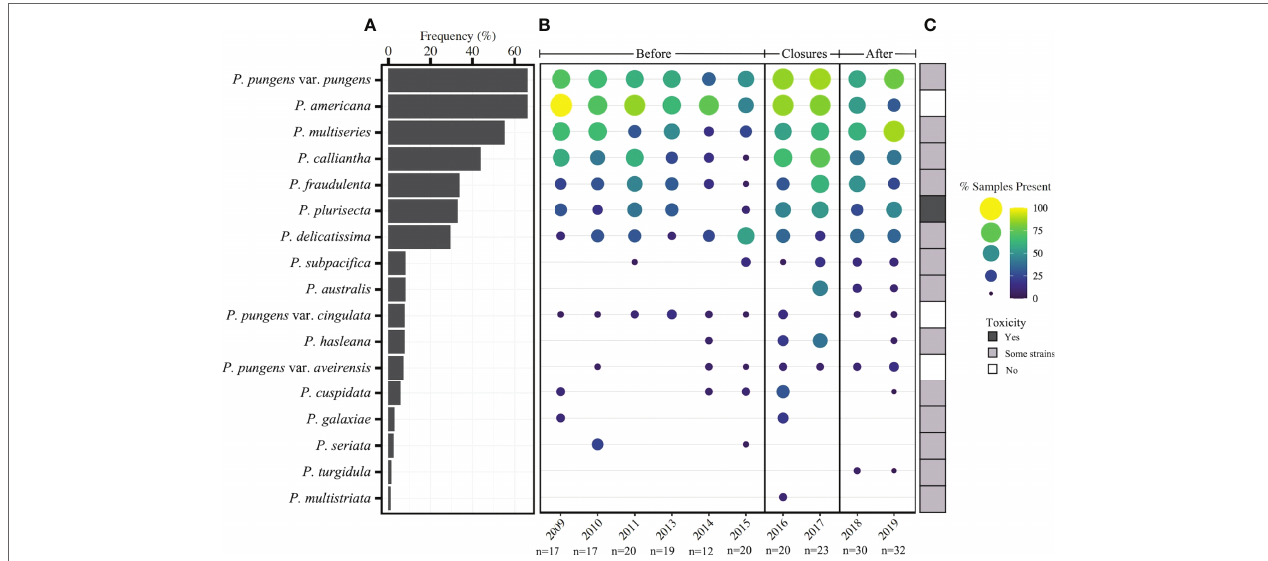
FIGURE 4 | (A) Frequency of occurrence of 17 species of Pseudo-nitzschia from 2008 – 2019 (n=214). (B) Presence of Pseudo-nitzschia species by year for three timeframes: prior to closures, during closure years, and following closures. The size and color of each circle represents the percent of samples in a given year in which Pseudo-nitzschia species occurred based on a presence/absence matrix. (C) Observed toxicity of each species as reviewed in Bates et al., 2018, with “some strains” meaning that some have been reported to produce toxin while others have